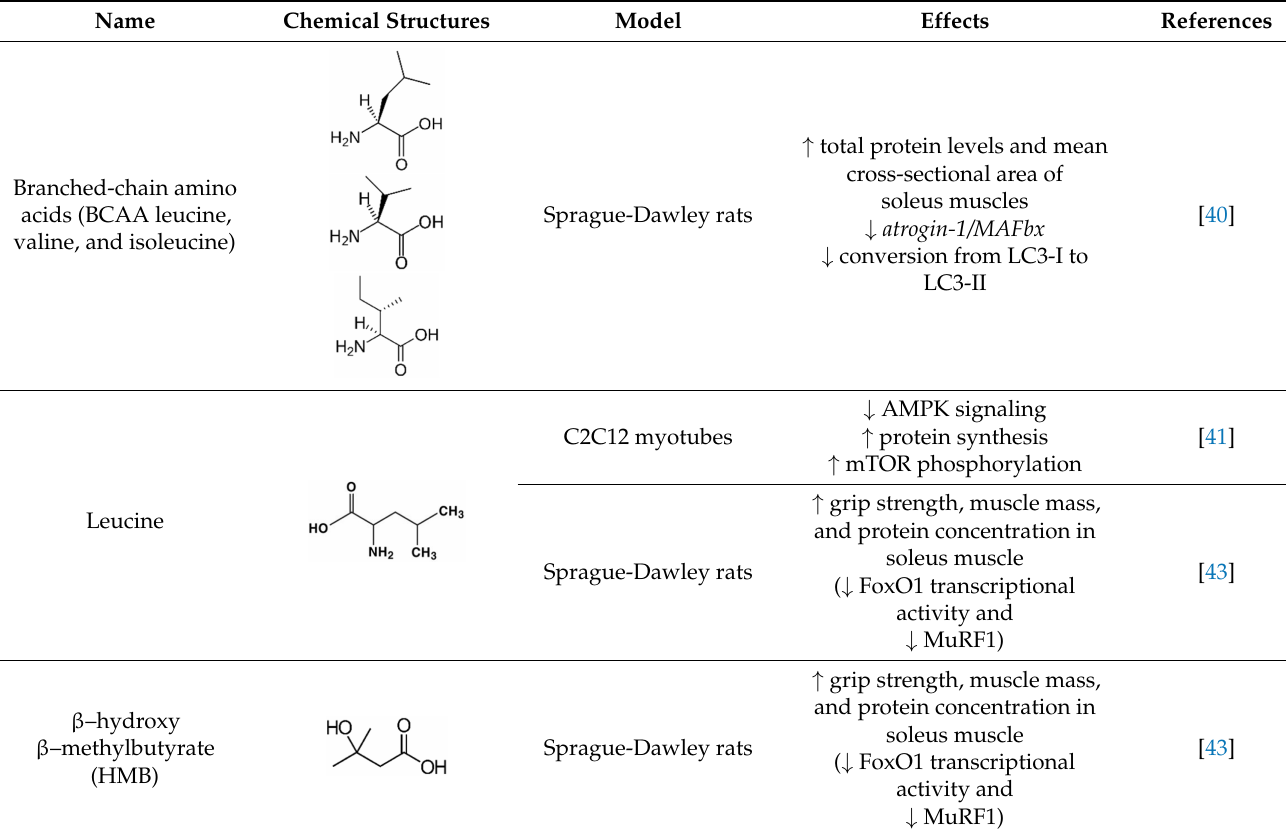
Table 1. The role of amino acids in glucocorticoid-induced muscle